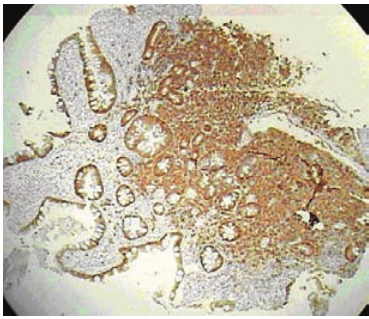
cending colon (Figure 5). The postoperative period was uneventful and the patient was discharged from the hospi- tal on the 5 th postoperative day. Peritoneal gavage cytol- ogy was negative for neoplasic cells and the histological study of the surgical sample confirmed the diagnosis of plasmocytoma of the jejunum (with free resection margins), including an inflammatory infiltrate in the colonic wall (Figure 6). Thirteen resected lymph nodes were free of dis- ease.